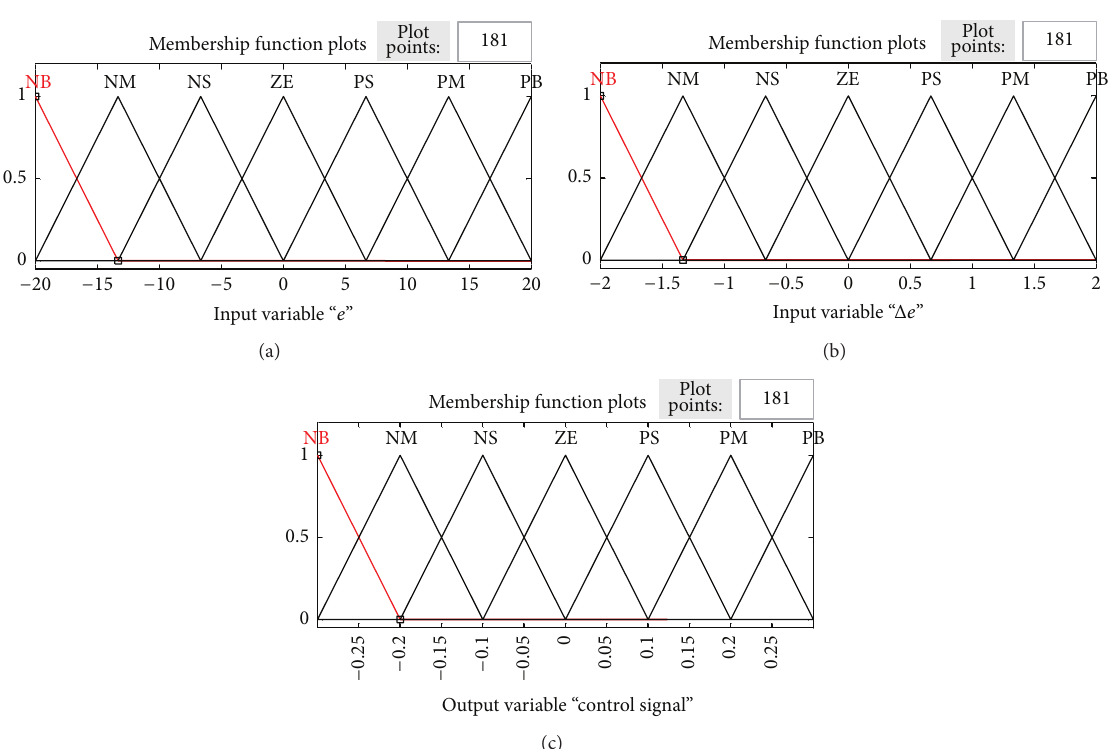
Figure 10: (a) Membership functions of error. (b) Change in error. (c) Control